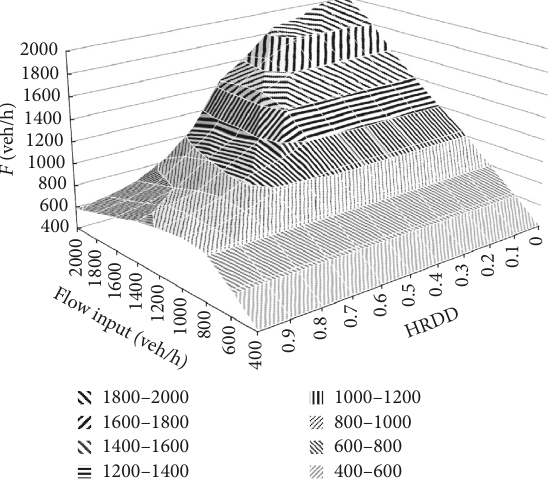
Figure 10: Relationship among F , flow input , and Figure 11. When HRDD is in the low-level range (0 ∼ 0.3), C is stably above 1800 pcu/h. When HRDD is in the moderate- level range (0.3 ∼ 0.8), C varied sharply and declines by up to 40%. When HRDD is in the high-level range (0.8 ∼ 1), the